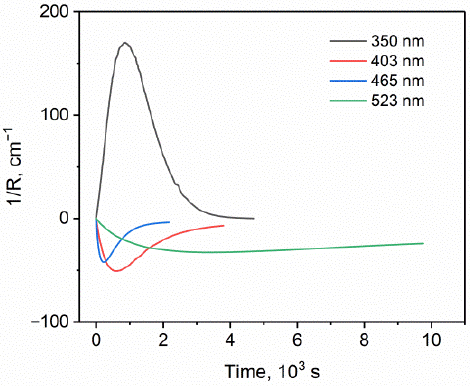
Figure 4. Dependences of the crystal curvature on the transformation time for different light sources.